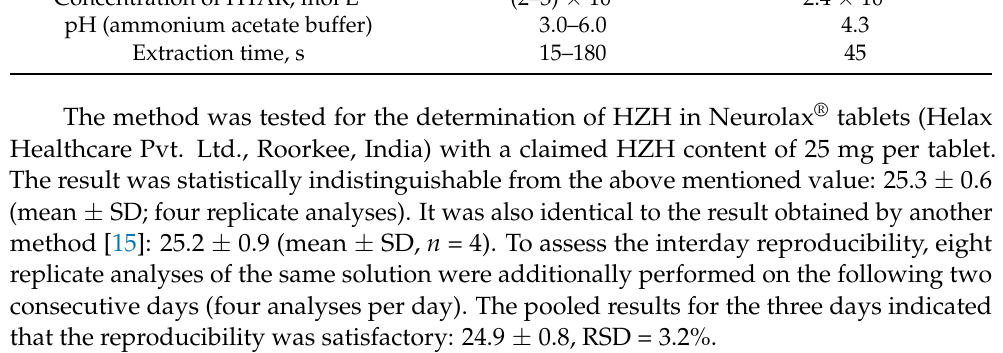
Table 3. Extraction–spectrophotometric optimization.